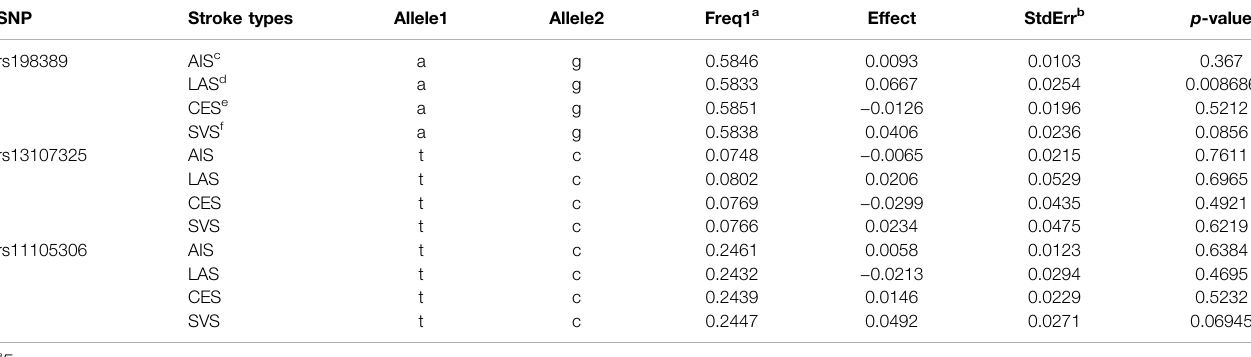
TABLE 2 | The genetic association analysis of BNPs and ischemic stroke and its subtypes. SNP